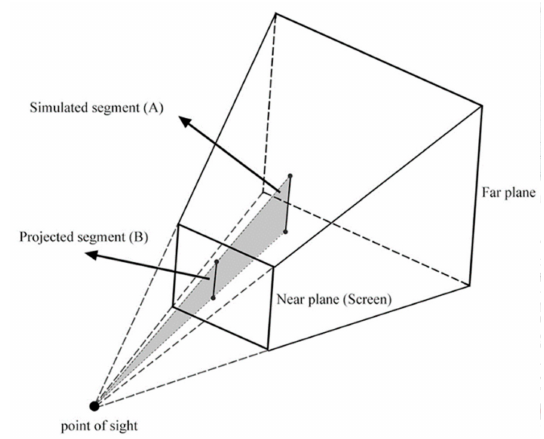
Figure 10. Method for defining the SVO threshold. Segment line A is a simulated segment whose length is calculated by MMQE and whose direction is always parallel to the screen. Segment B is the representation of segment A, projected onto the screen. When the length of segment B on the screen is 1 pixel or a custom unit pixel, the length of segment A can be defined as the SVO threshold for the scale transition of the terrain model. Each scale of the model has a corresponding SVO threshold. When the visual distance is changed, the SVO threshold requirement is also changing.